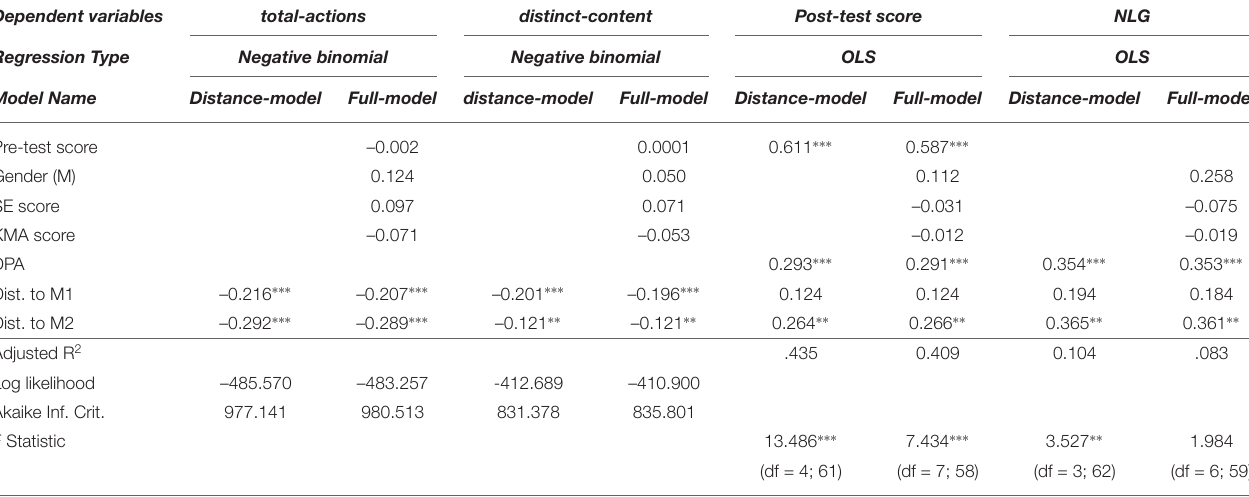
TABLE 8 | Summary of the fitted regression models to predict engagement and performance